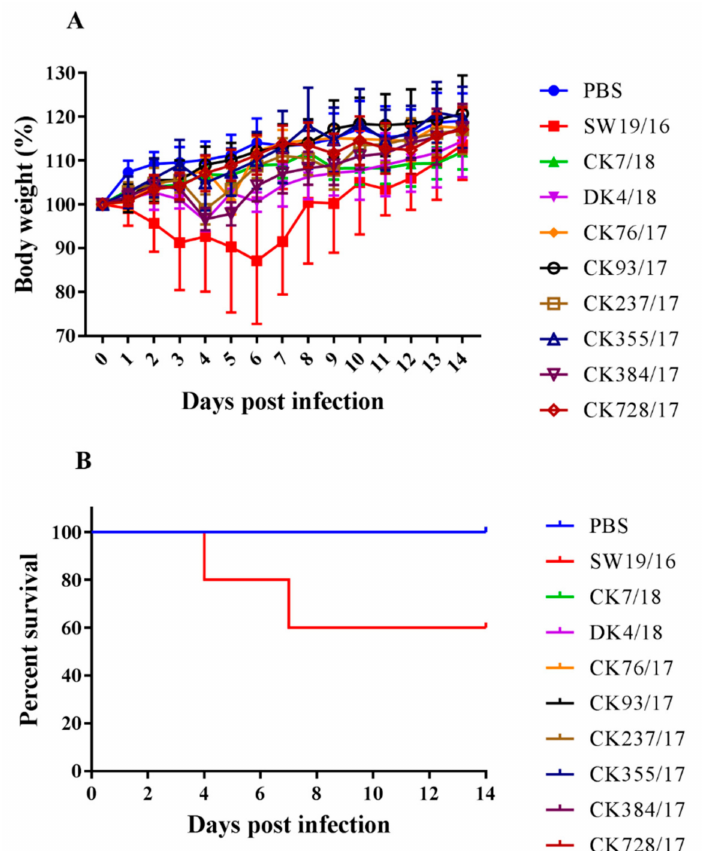
Figure 4. Variation of body weight ( A ) and survival ( B ) of mice inoculated with viruses. Eighty 6-week-old female BALB / c mice were randomly divided into ten groups. Each group contains eight mice. One group of mice were anesthetized with isoflurane and intranasally inoculated with 100 µ L PBS as a negative control. One group of mice were anesthetized and intranasally inoculated with SW19 / 16, at a dose of 10 5 EID 50 , in 100 µ L. The other eight groups of mice were anesthetized and intranasally inoculated with corresponding H9N2 viruses, respectively, at a dose of 10 6 EID 50 , in 100 µ L. In each group, three mice were euthanized and brains, spleens, kidneys, and lungs were collected at 3 dpi. The remaining mice were continually weighed until 14 dpi. Table 2. Virus titer in di ff erent organs of mice.